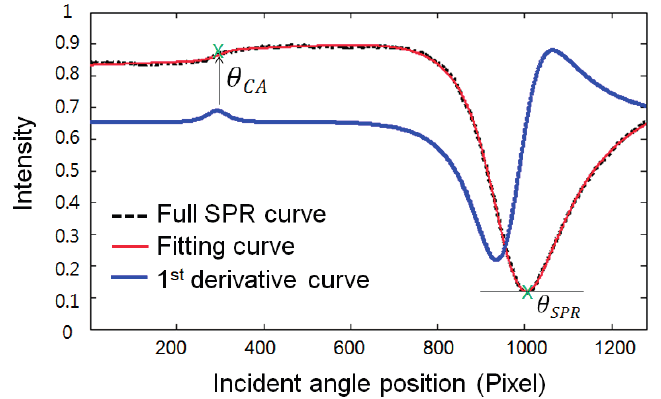
Figure 4. Determination of a resonance angle and a critical angle using sigmoid- asymmetric curve fitting: full SPR curve (black dotted line) plotted from the final image is first fitted by the sigmoid-asymmetric equation (red solid curve), and the resonance angle and critical angle are simultaneously and automatically determined after calculating the 1st derivative (blue solid